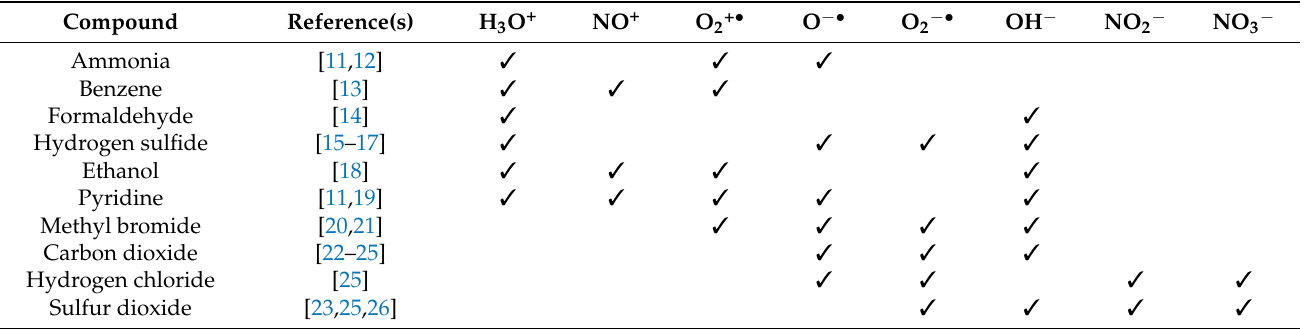
Table 2. Examples of compounds and the SIFT-MS reagent ions by which they are practically analyzed (i.e., sufficient sensitivity and